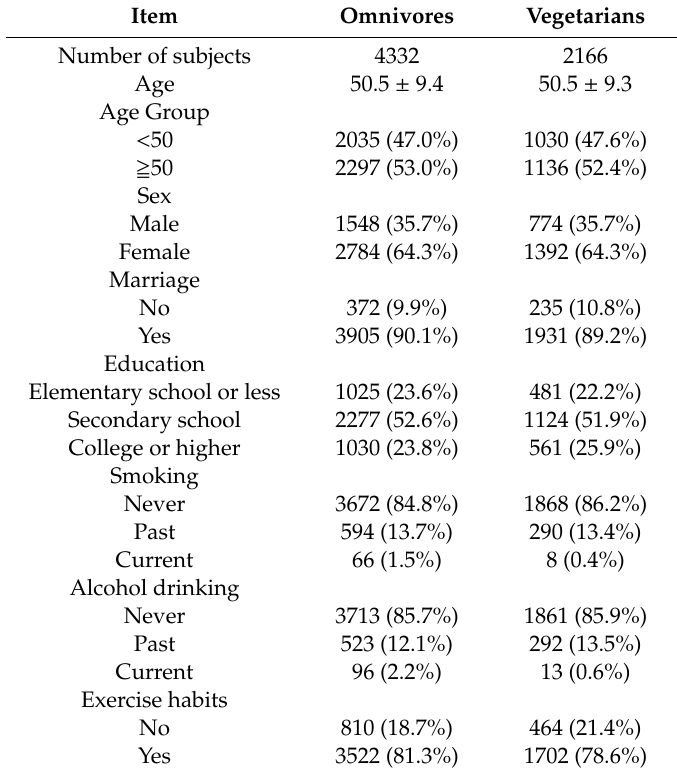
Table 1. Demographic and lifestyle characteristics of vegetarians and omnivores.